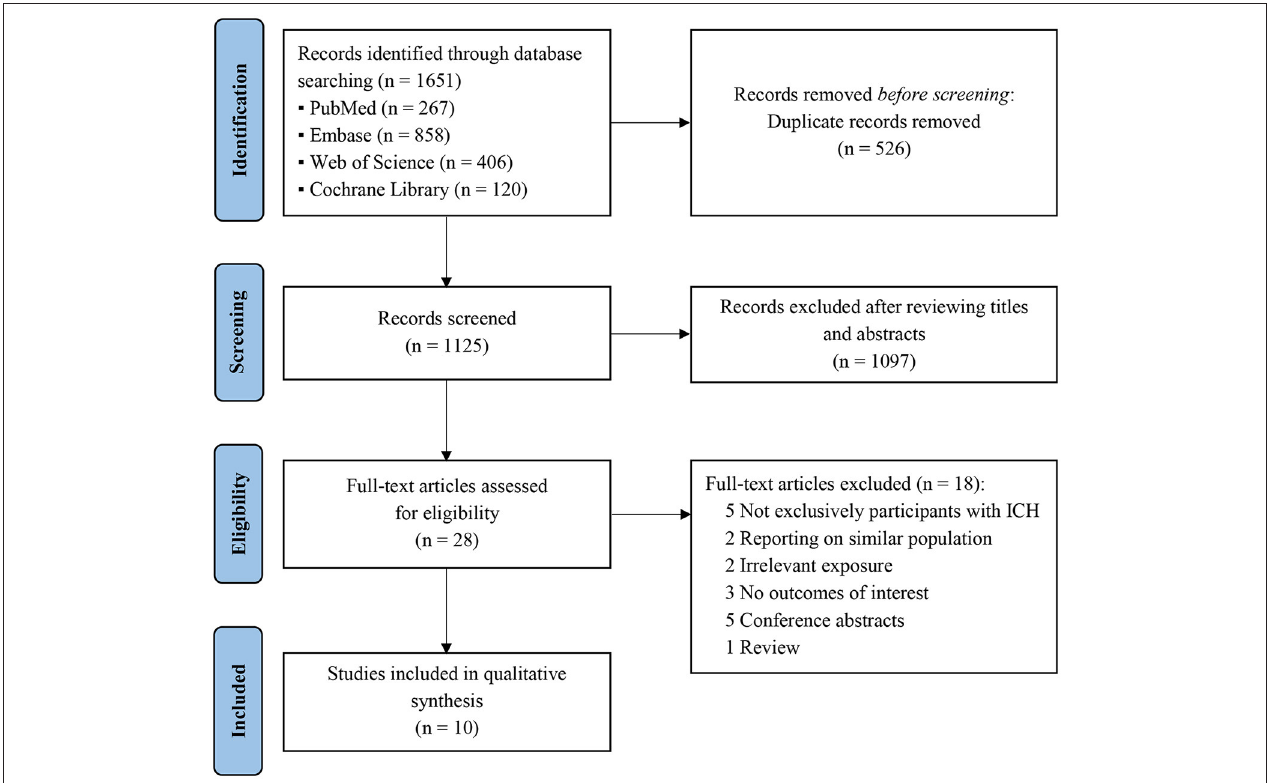
FIGURE 1 | PRISMA flow diagram representing the search and selection process. ICH, intracerebral